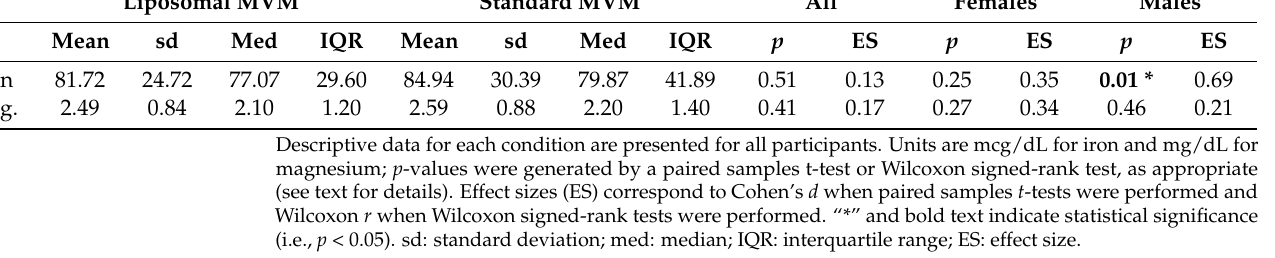
Descriptive data for each condition are presented for all participants. Values are in units of incre- mental area under the time (hours) vs. the concentration curve. Concentration units are mcg/dL for iron and mg/dL for magnesium. p -values were generated by a paired samples t -test or Wilcoxon signed-rank test, as appropriate (see text for details). Effect sizes (ES) correspond to Cohen’s d when paired samples t -tests were performed and Wilcoxon r when Wilcoxon signed-rank tests were per- formed. “*” and bold text indicate statistical significance (i.e., p < 0.05). sd: standard deviation; med: median; IQR: interquartile range; ES: effect size. Table 5. Maximal observed concentration (Cmax) comparison. Table 5. Maximal observed concentration (Cmax) comparison.